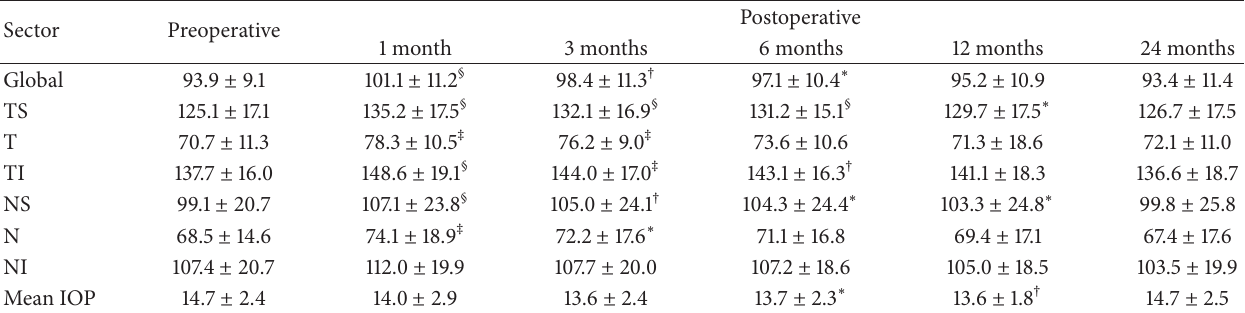
Table 3: Comparison of circumpapillary global and sectoral RNFL thickness ( 𝜇 m) and intraocular pressure (mmHg) during 24-month follow-up period ( 𝑛 = 22 ).